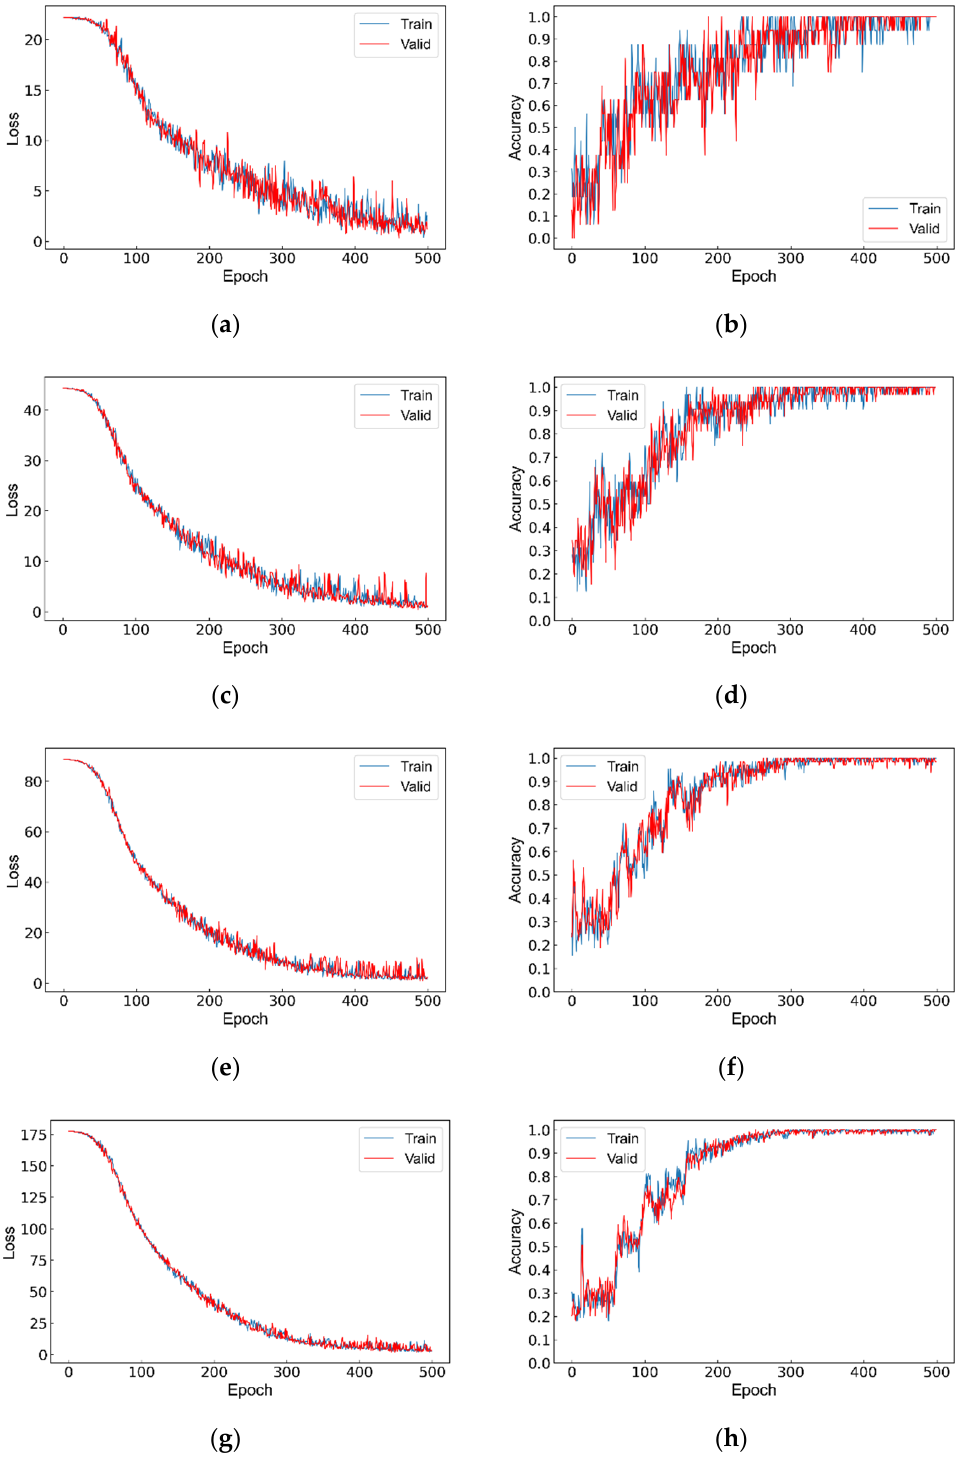
Figure 8. The effect of varied batch size on the stability of model convergence. ( a , b ) batch size = 16; ( c , d ) batch size = 32; ( e , f ) batch size = 64; ( g , h ) batch size = 128.